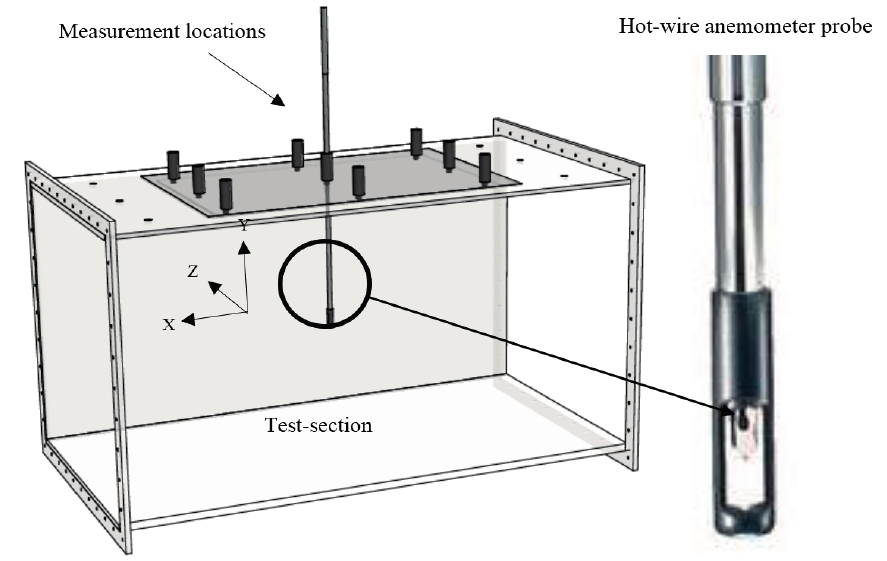
Figure 3. Schematic representation of the heating elements inside the